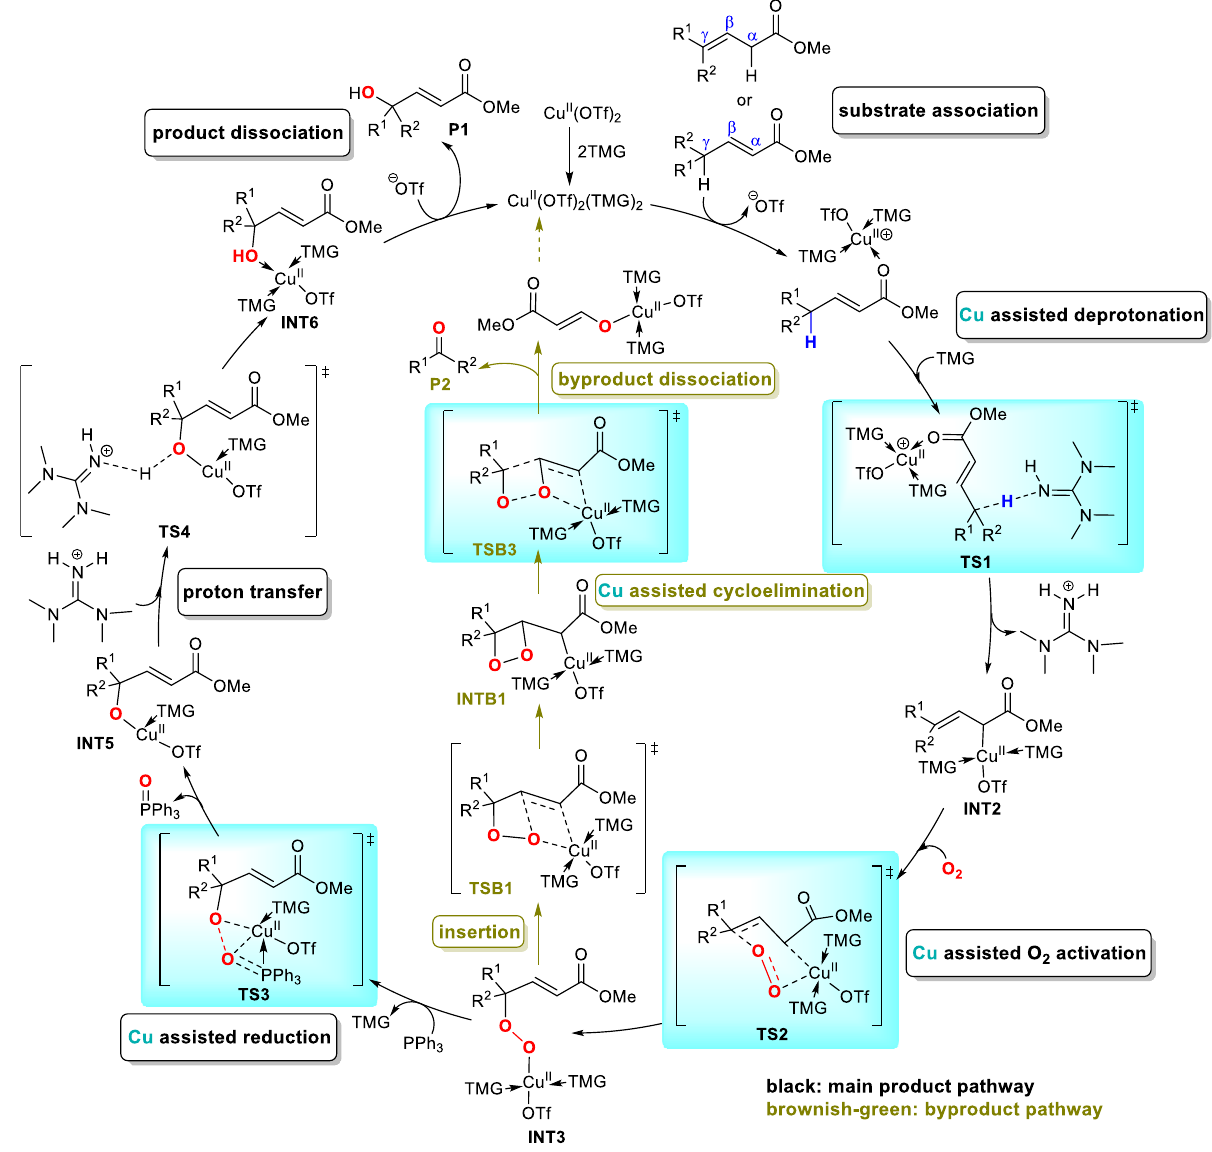
Figure 6. The proposed catalytic cycle for the copper-catalyzed vinylogous aerobic oxidation of α , β - and β , γ - unsaturated